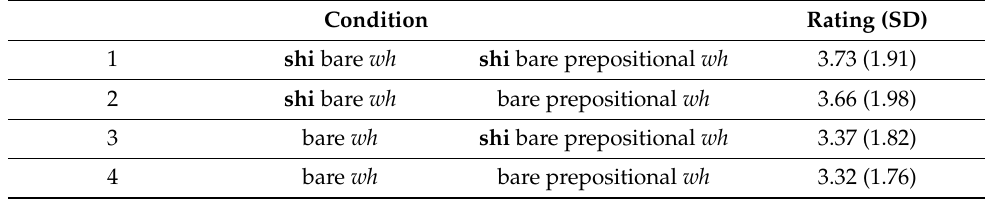
Table 10. Mean acceptability ratings in sub-experiment 3.